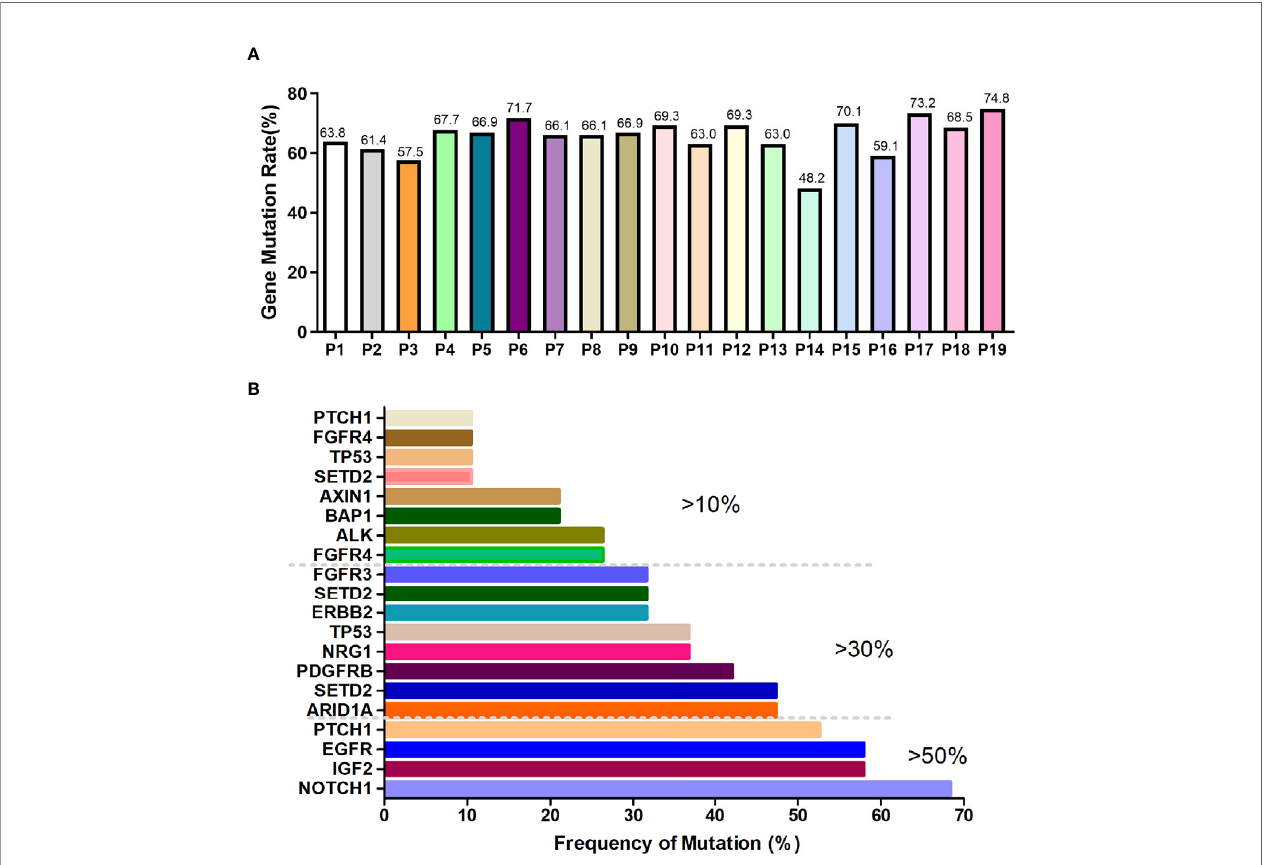
FIGURE 2 | CTC NGS analysis of cancer-related gene mutations in lung cancer patients. (A) Proportion of mutated genes in 19 lung cancer patients. (B) >10%, >30%, >50% of patients with mutated